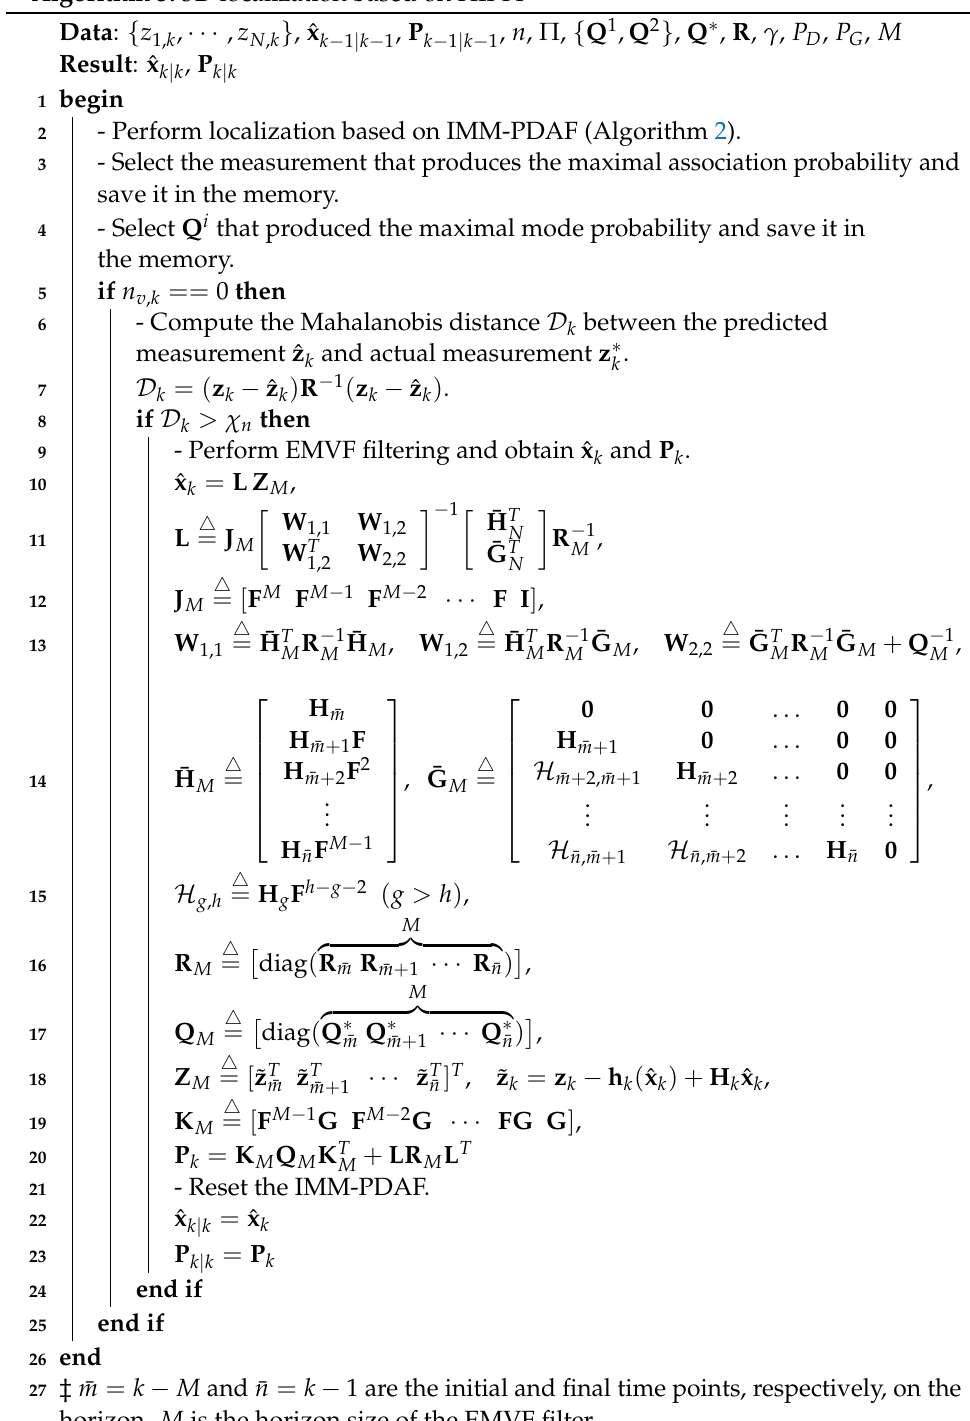
Algorithm 3: 3D localization based on